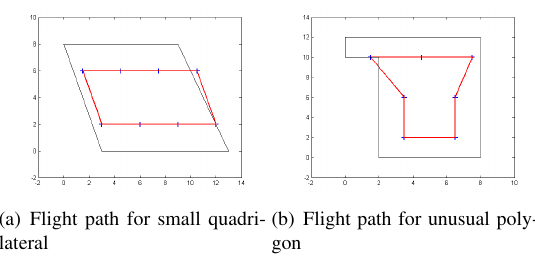
Figure 8: Predicted flight paths of polygons